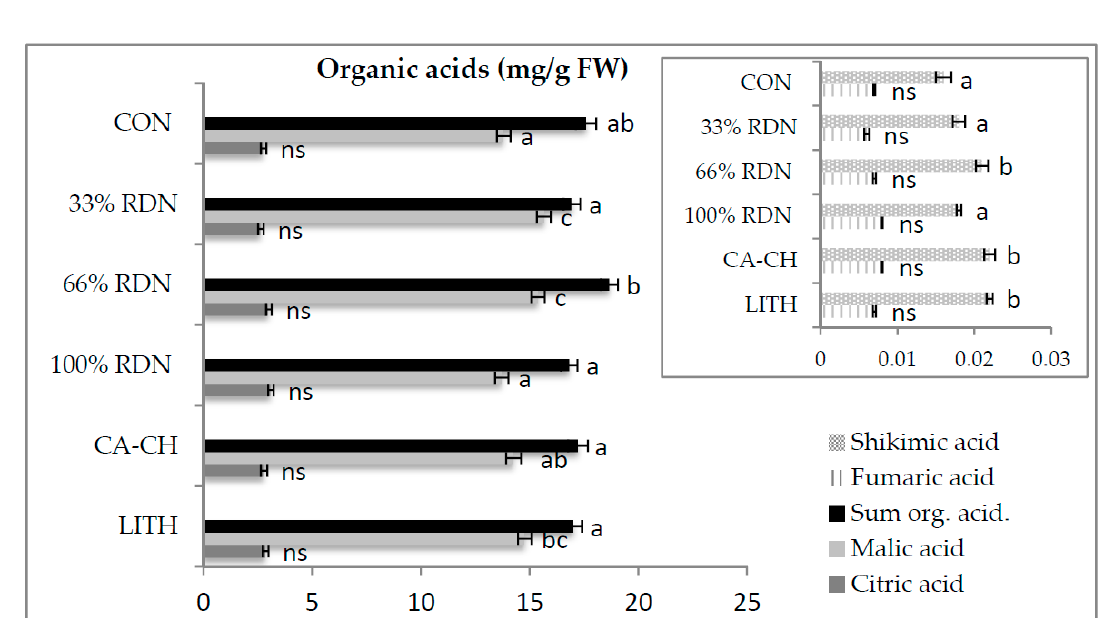
Figure 3. Strawberry sugar content following six treatments (33%, 66% and 100% RDN, CA-CH, LITH and CON). Average means ( n = 10) ± standard errors are shown. Different letters between treatments denote significant differences (Tukey test, p < 0.05). RDN—recommended dose of nitrogen; CA-CH—calcium chelate; LITH—Lithovit; CON—control.